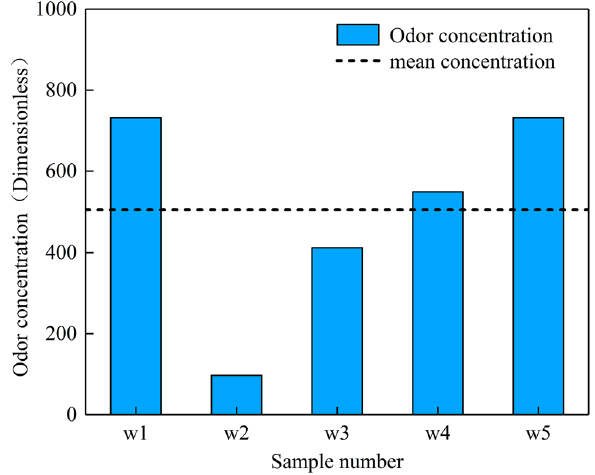
Fig. 5. The unorganized odor concentration in the crema- tion workshops was 97-732 (504 on average), indicating